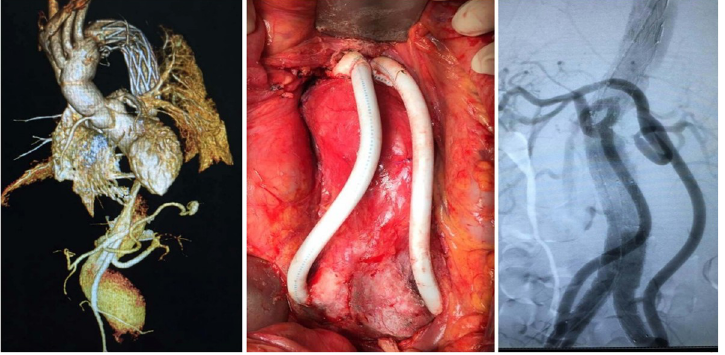
Fig 1. Hybrid treatment for Crawford type III TAAA with Marfan syndrome. Left: the preoperative CTA image of TAAA; Middle: the retrograde revascularization from bilateral CIA; Right: The angiography of DSA for the RVR with bilateral CIA following hybrid